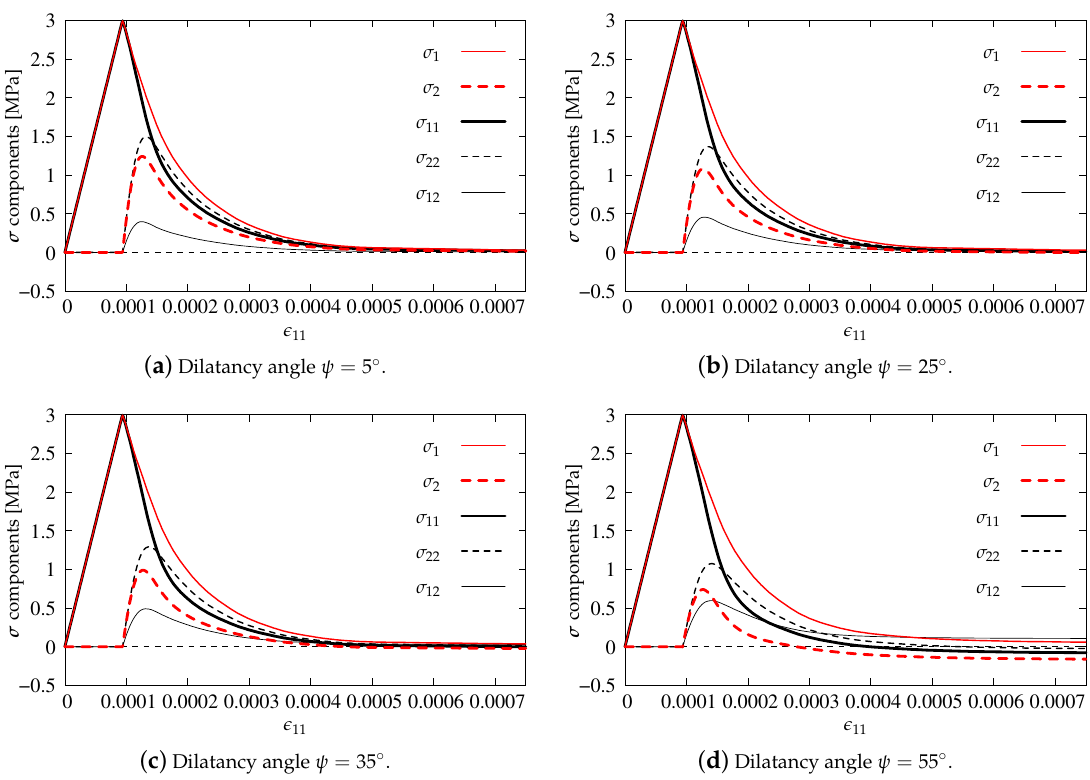
Figure 9. Comparison of stress components for CDP model—pure